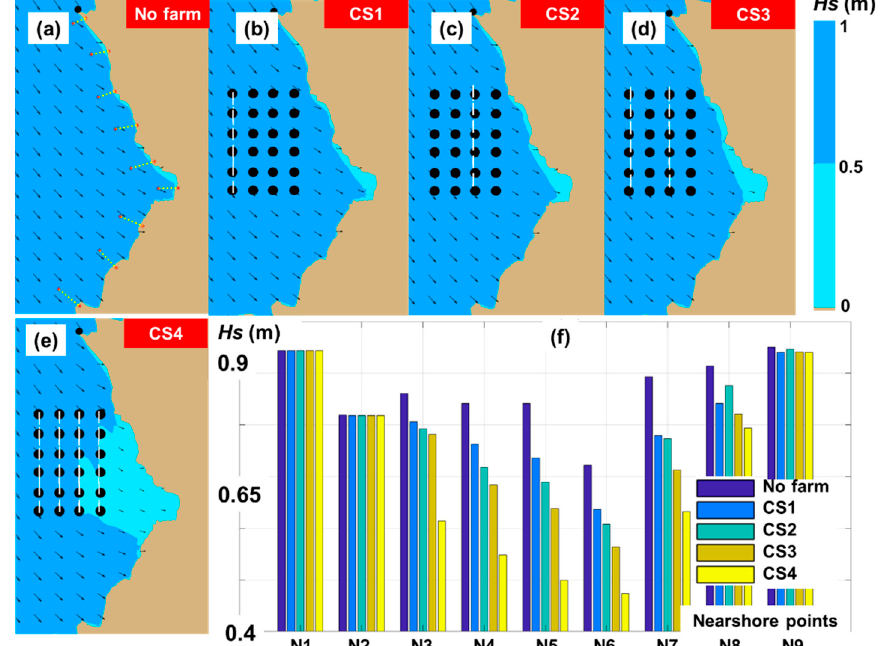
Figure 6. Influence of the generic marine farm taking into account an energetic summer event (case Summer A as defined in Table 2). The results correspond to: ( a – e ) Hs spatial variations considering various scenarios; ( f ) distribution of the Hs values near the nearshore points N1–N9. The arrows in the plots represent the wave direction.